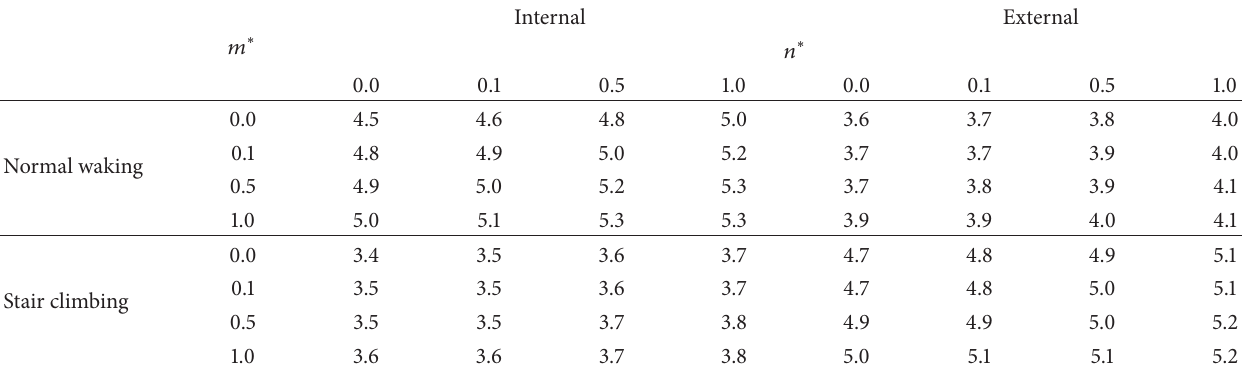
Table 7: Summary of maximum principal stress on the cement layer.